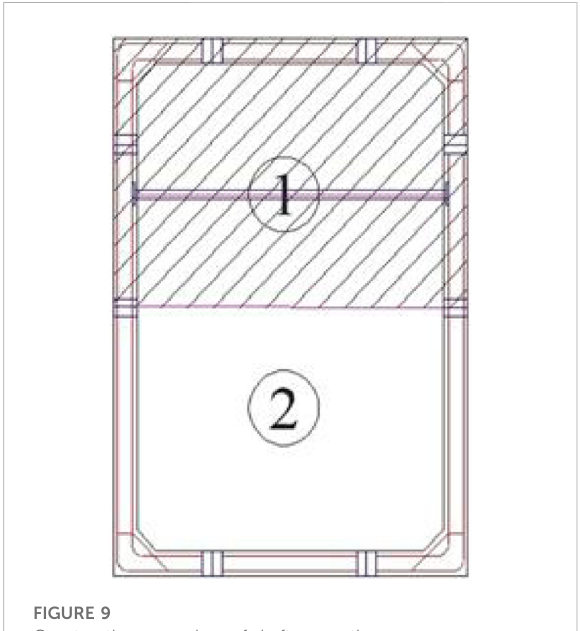
FIGURE 9 Construction procedure of shaft